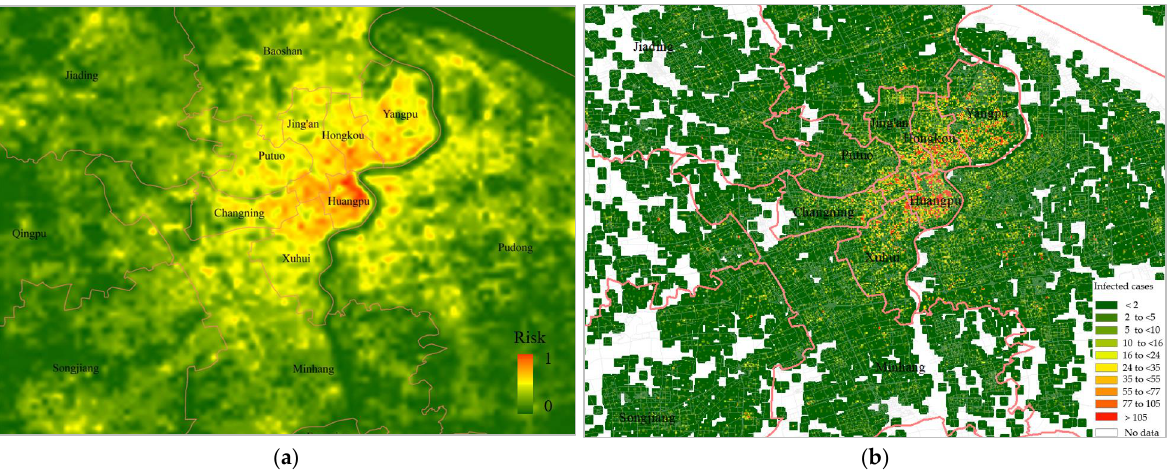
Figure 6. Mapped infection risk in Shanghai using the proposed regression model. ( a ) Predicted infection risk map; ( b ) Actual observed infected cases as reference.